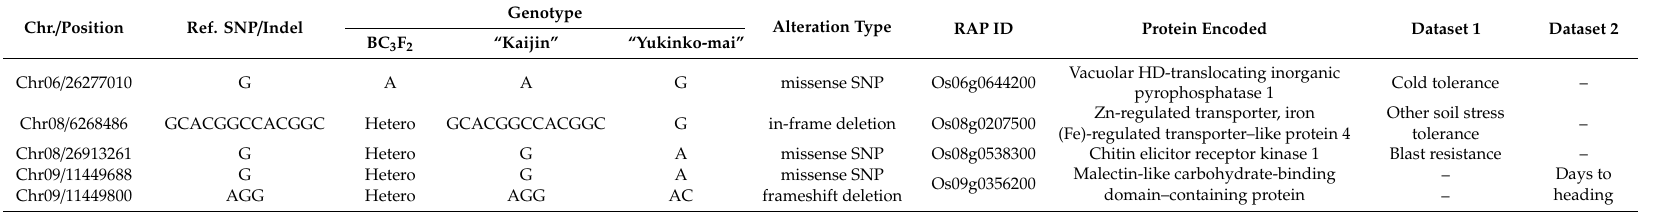
Table 2. List of agronomic-trait-related genes harboring alternative protein sequences in BC 3 F 2 #31-2-4. Chr., chromosome; Ref., Nipponbare reference allele; Hetero, heterozygous. Dataset 1, Overview of Functionally Characterized Genes in Rice Online database (OGRO) [52]; Dataset 2, potential agronomic functional gene set by gene-based GWAS of Japanese rice population